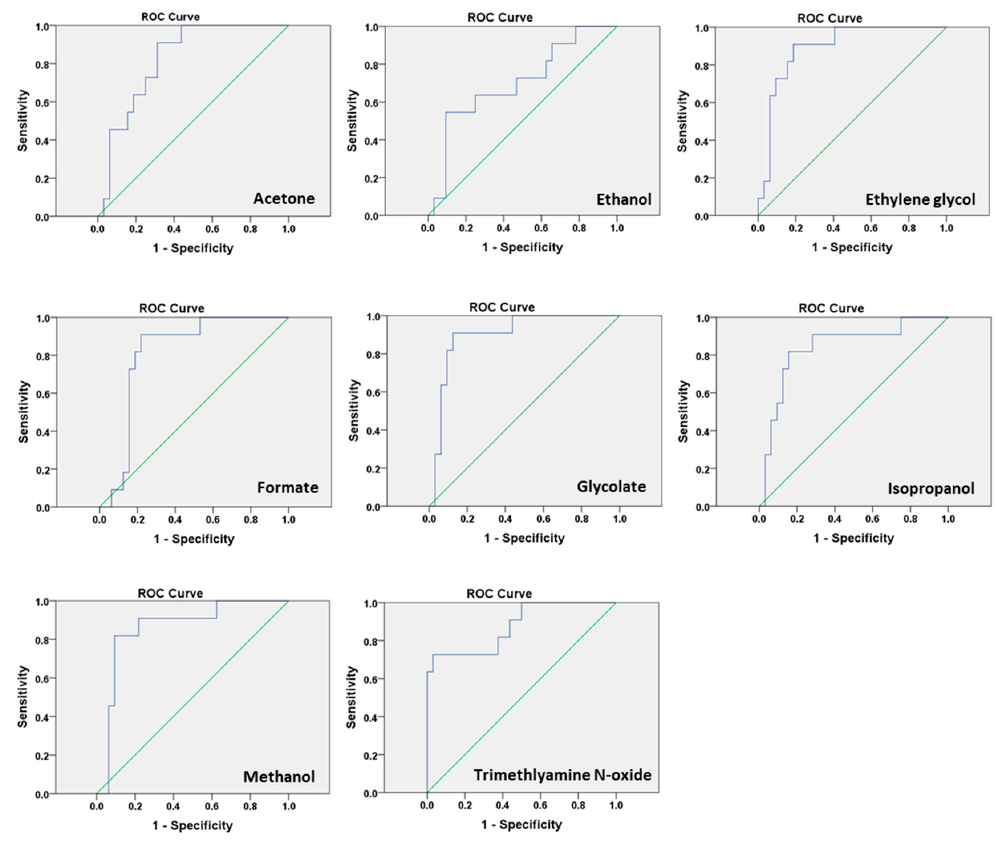
Figure 4. Receiver operating characteristics (ROC) curve analysis for metabolites: predictive performance of the biomarker for preterm birth using ROC curves of sensitivity and specificity. Table 3. Correlation analysis between the metabolites and clinical